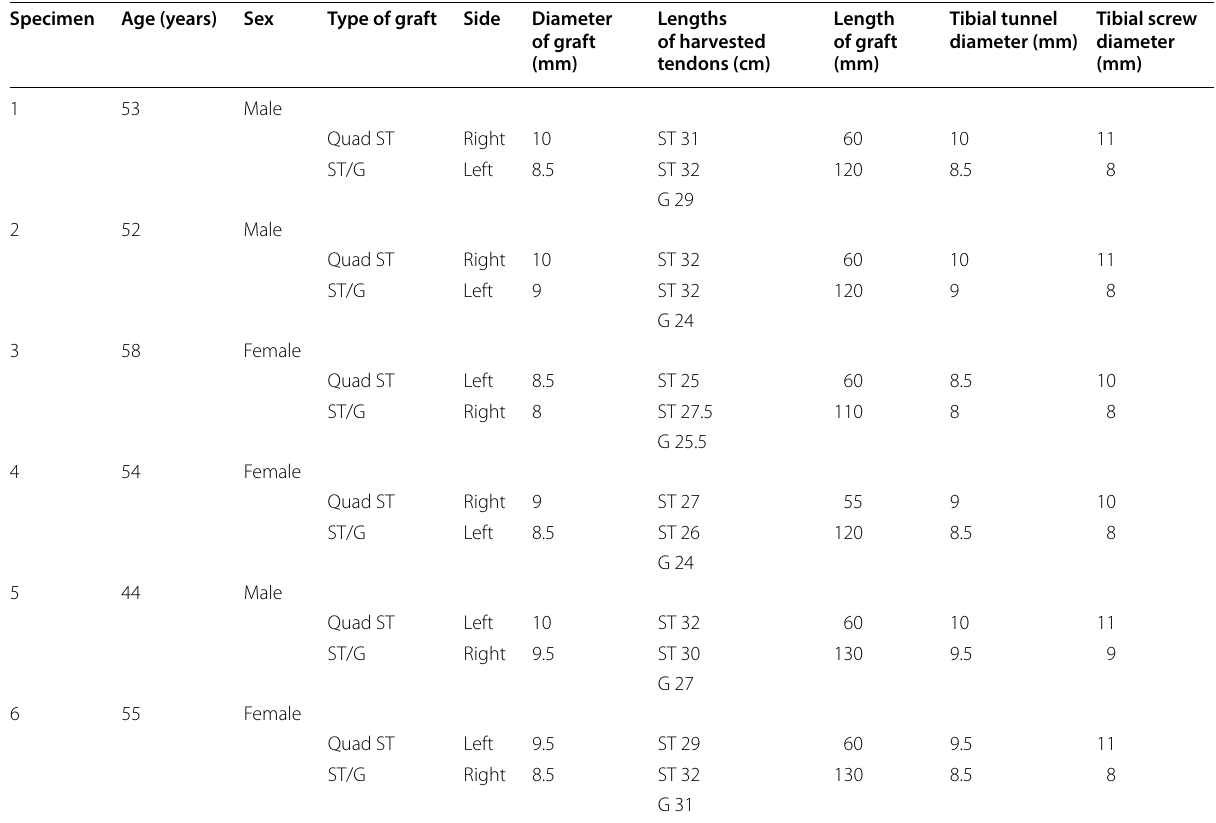
Table 1 Diameter of quadrupled semitendinosus and doubled semitendinosus–gracilis